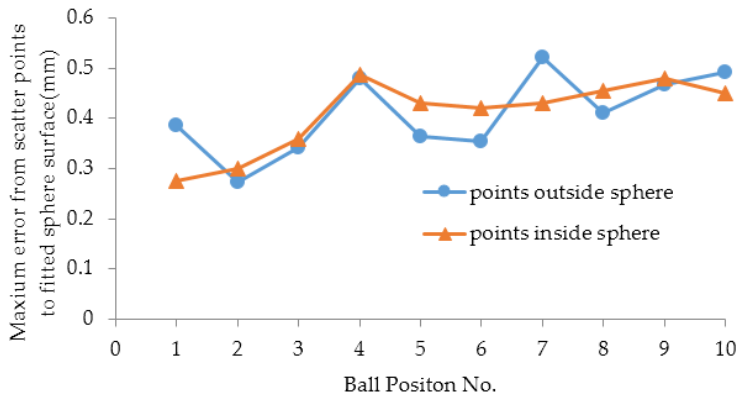
Figure 9. The maximum distance from the points outside and inside the sphere to the fitted surface.